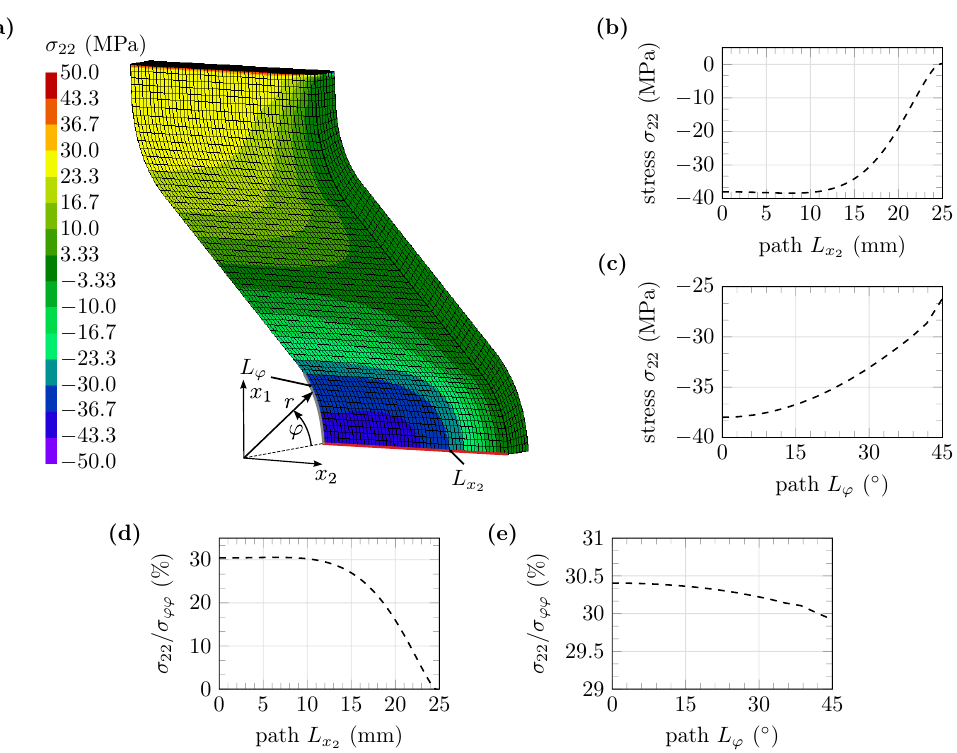
Figure 5. Numerical simulation of the structural component made of AZ31B with bending radius R BS12 = 12mm: ( a ) stress field σ 22 ( r , ϕ , x 2 ) of a FEM quarter model at a given load of F = x 1 -direction; ( b ) stress σ 22 over the path L x ; ( c ) stress σ 22 over the path L ϕ ; ( d ) stress ratio σ 22 / σ ϕϕ 2 over the path L x ; ( e ) stress ratio σ 22 / σ ϕϕ over the path L ϕ 2